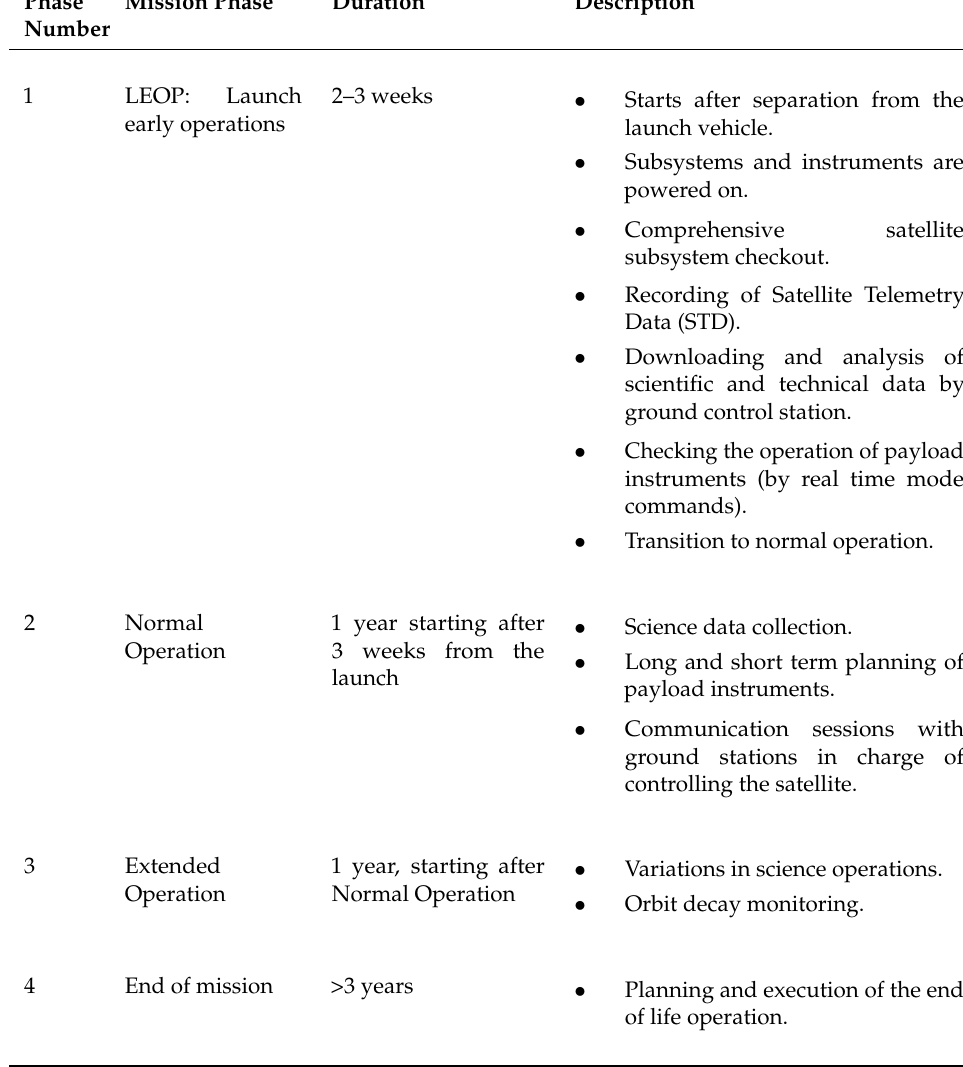
Table 2. Satellite mission operation